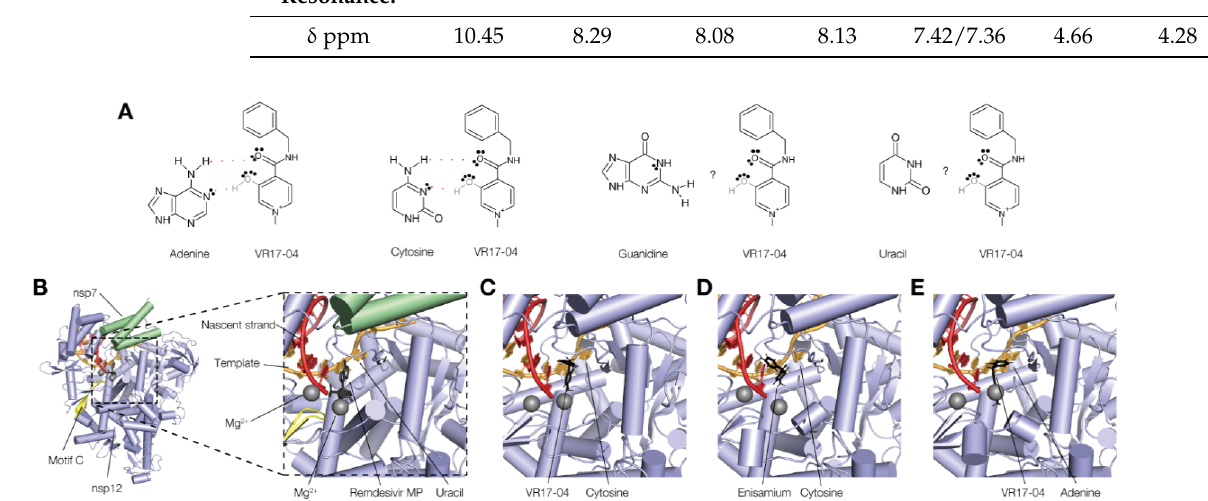
Table 2. 1 H chemical shift of the VR17-04 in water at T = 277 K acquired at 500 MHz. The labelled resonances are reported on the NOE spectra in Figure 4B.